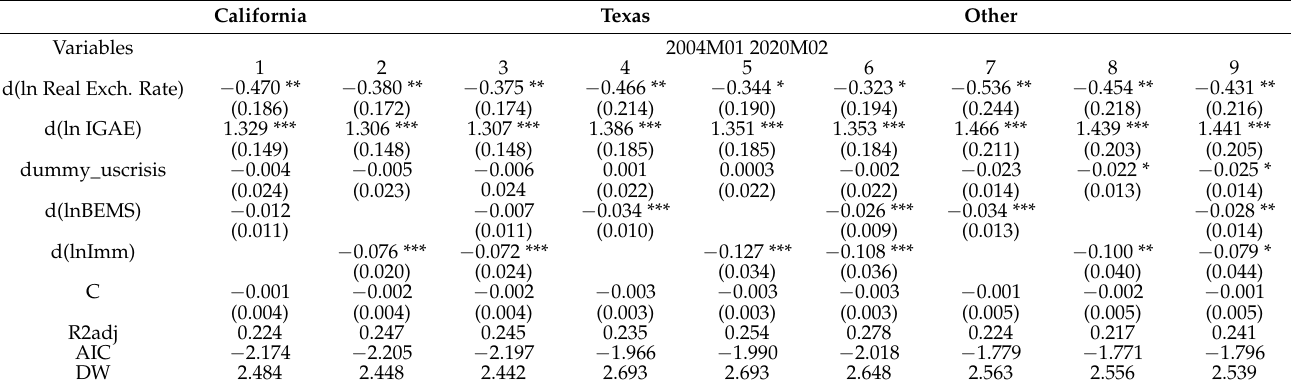
Table 7. Pedestrian crossings OLS regression results clustered by regions (period: 2004-2020M02).